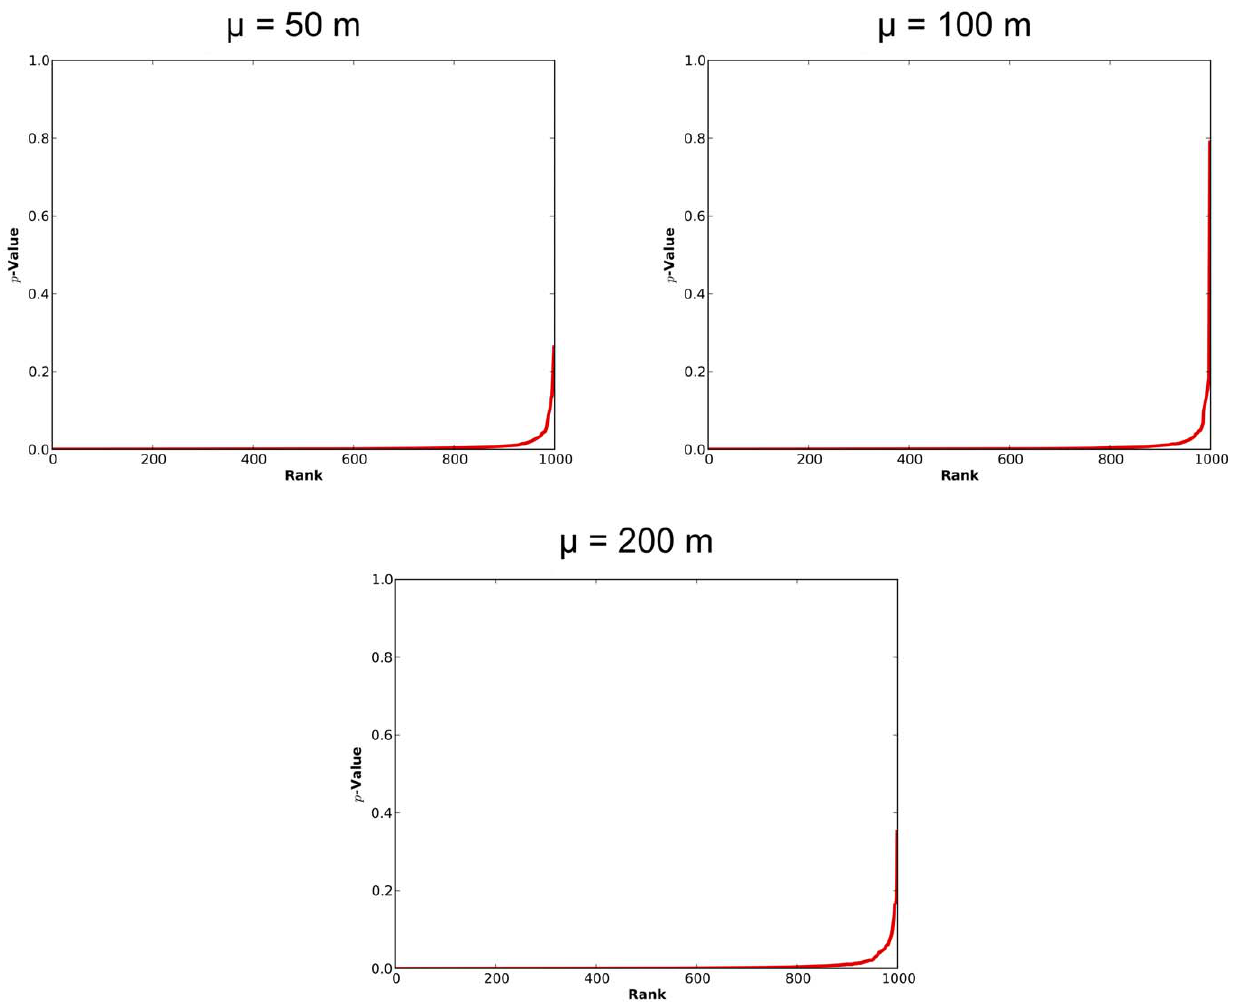
Figure 9. Pseudo p -values determined by the STPSS for likely clusters identified in the vicinity of the original Cluster 1 ( red solid line ) and 2 ( green dashed line ) in each perturbed version of the original datasets.